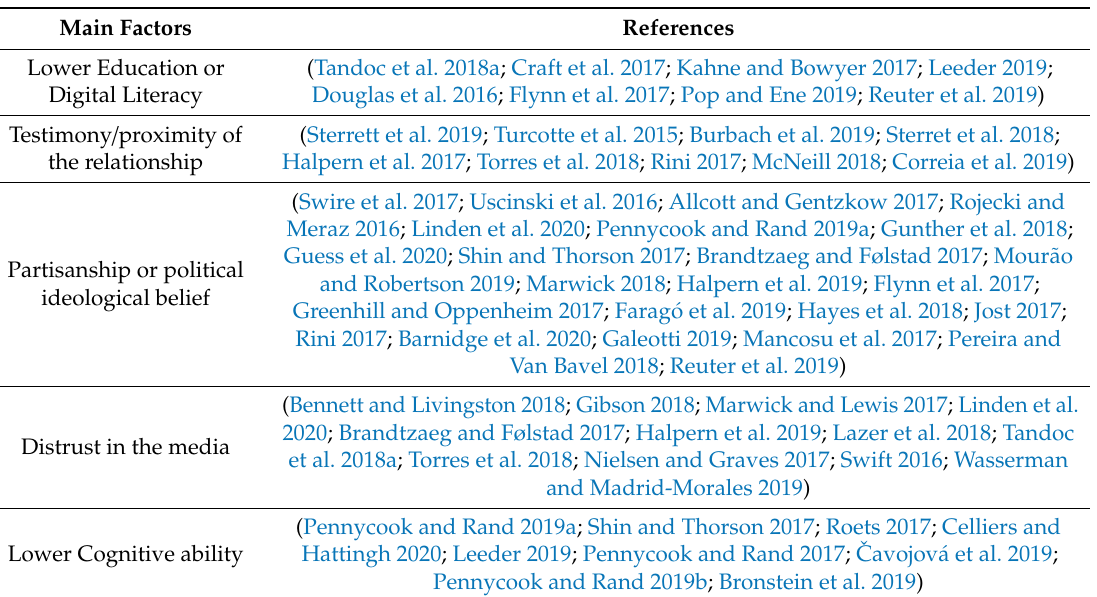
Table 2. Literature review: main factors that influence the belief in disinformation and misinformation online